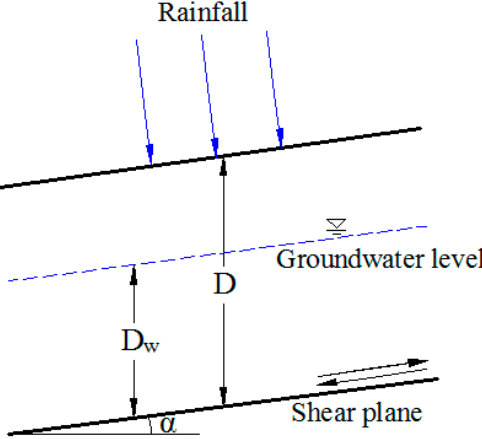
Figure 2. Mechanism of rainfall-induced landslides.